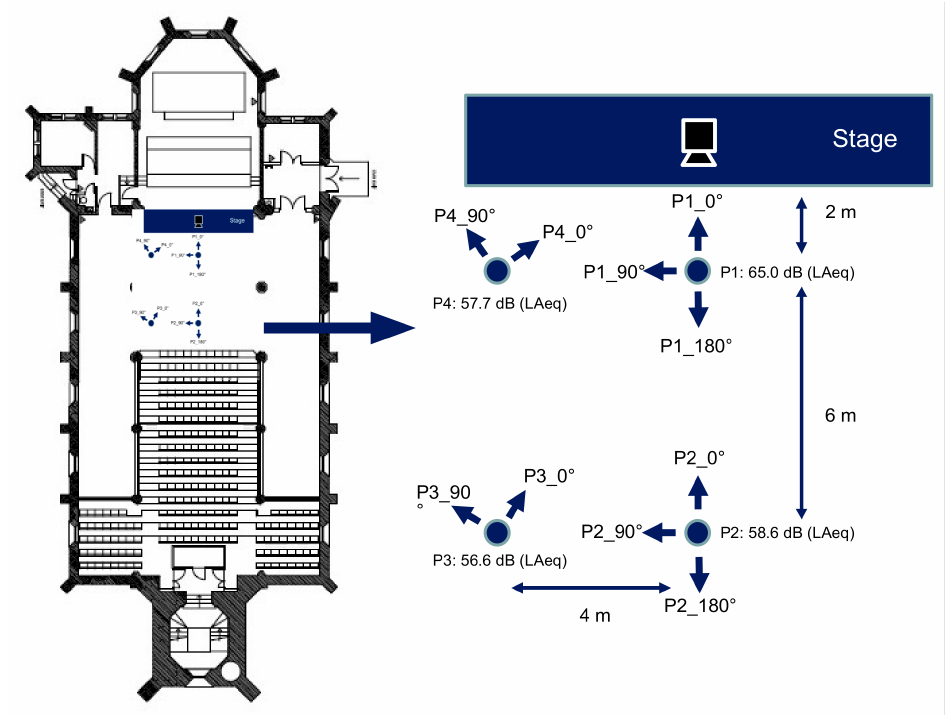
Figure 1. The top view of the St. Paul’s concert hall and the listener positions and orientations used for the elicitation